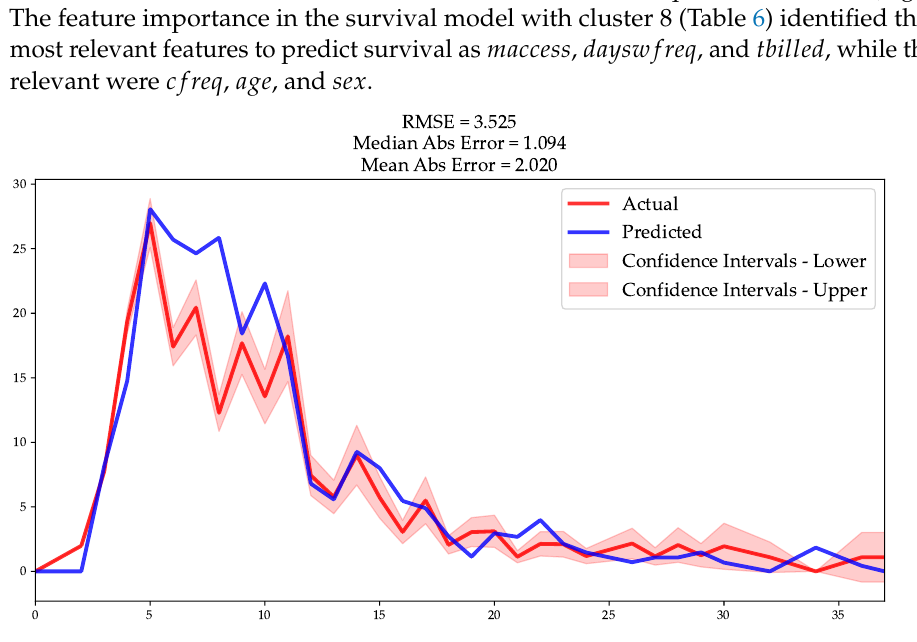
Figure 13. Conditional survival forest for cluster